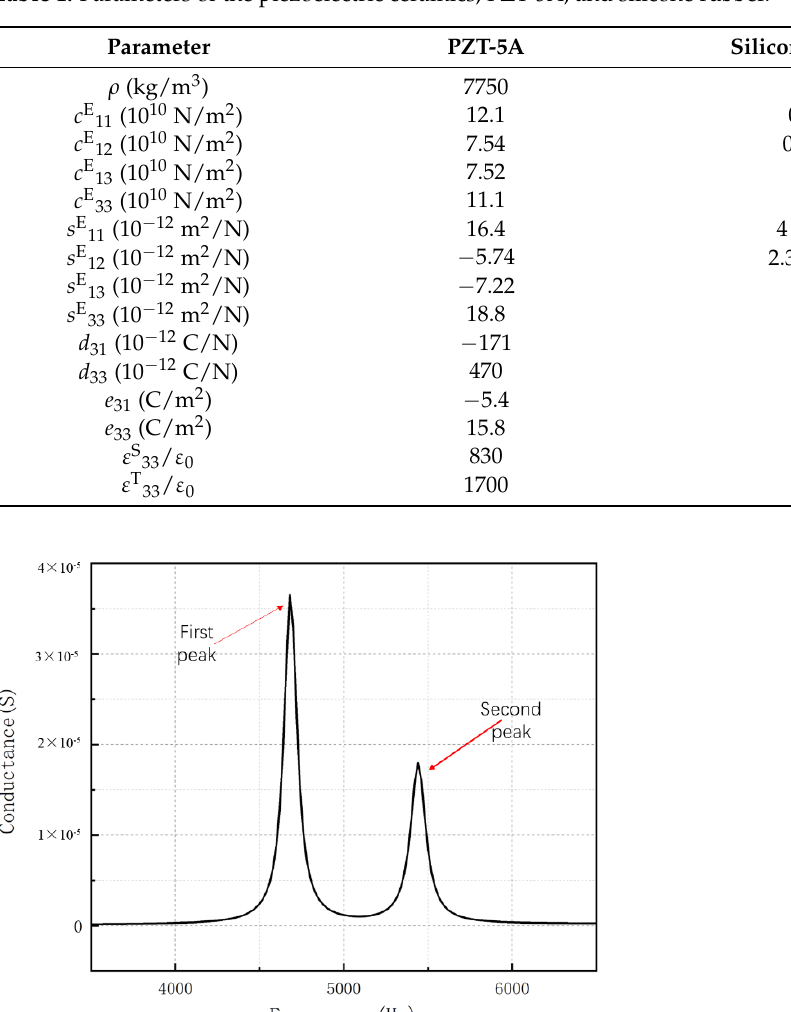
Table 1. Parameters of the piezoelectric ceramics, PZT-5A, and silicone rubber.